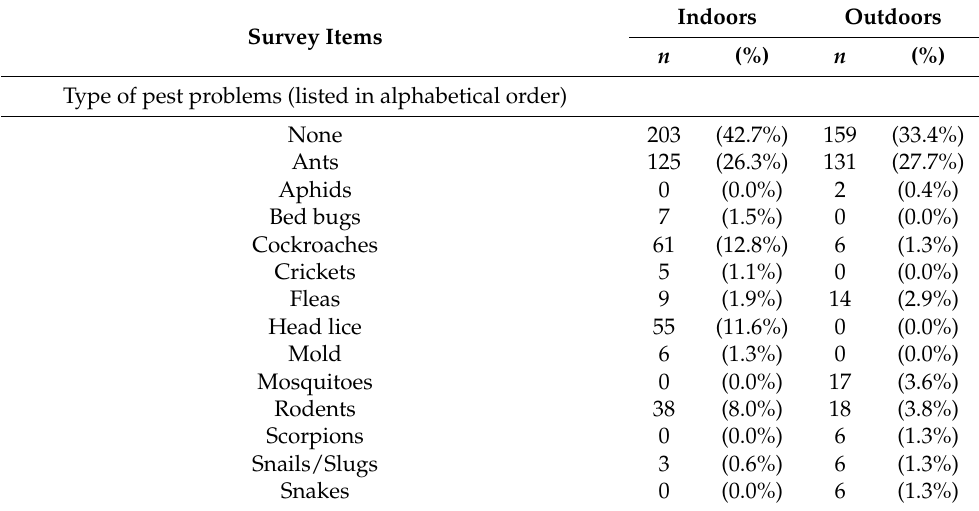
Table 5. Reported pest problems, pest control methods, applicators, frequency, and related